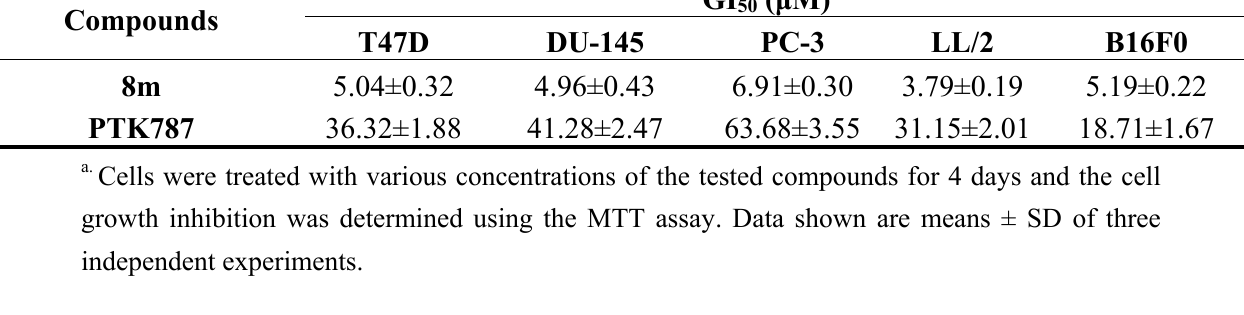
Table 2 . Antiproliferative effects of compound 8m and PTK787 in several tumor cell lines.